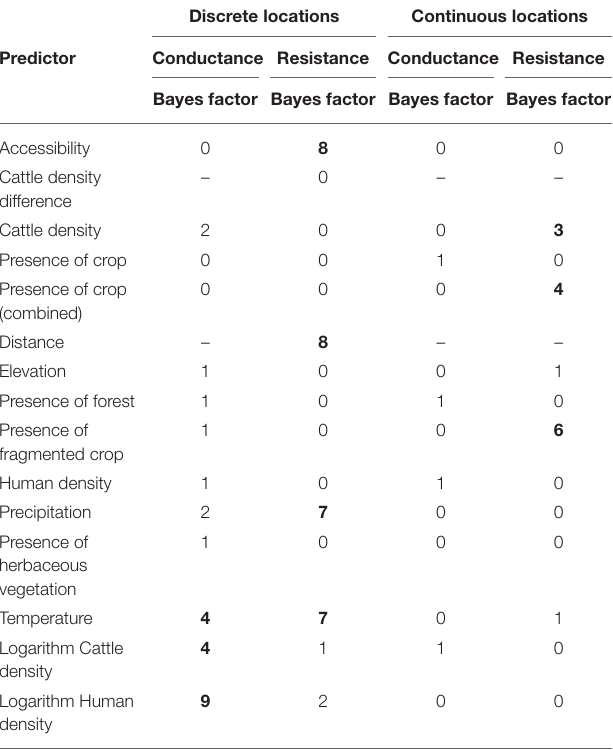
TABLE 2 | Bayes factor values associated with the effect of each predictor on the connectivity between the sampled locations using a discrete or continuous location